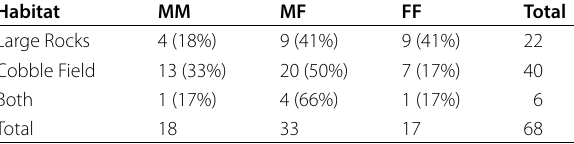
Table 6 Site 1 social links (network edges) by habitat type